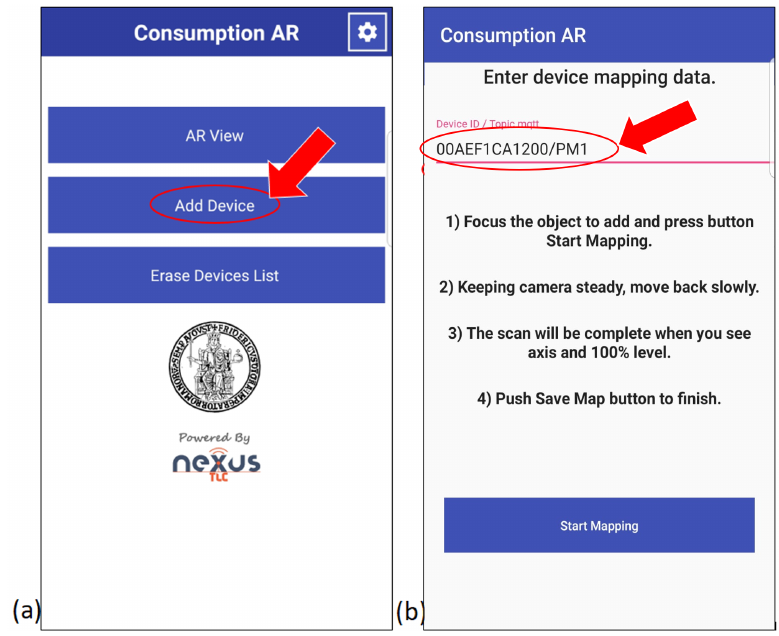
Figure 13. Screenshot of AR app for topic association and features extraction.